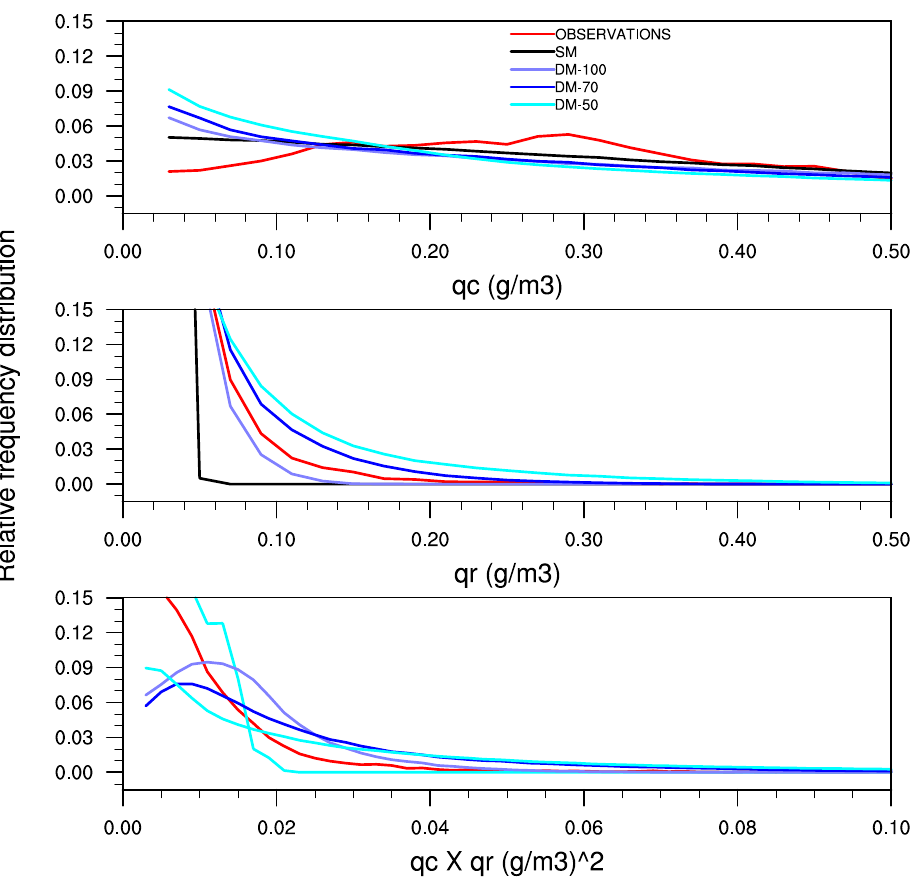
Fig. 7. Relative frequency distributions of q c , q r and q c × q r for observations and LES simulations of Figure 7: Relative frequency distributions of q DYCOMS-II.